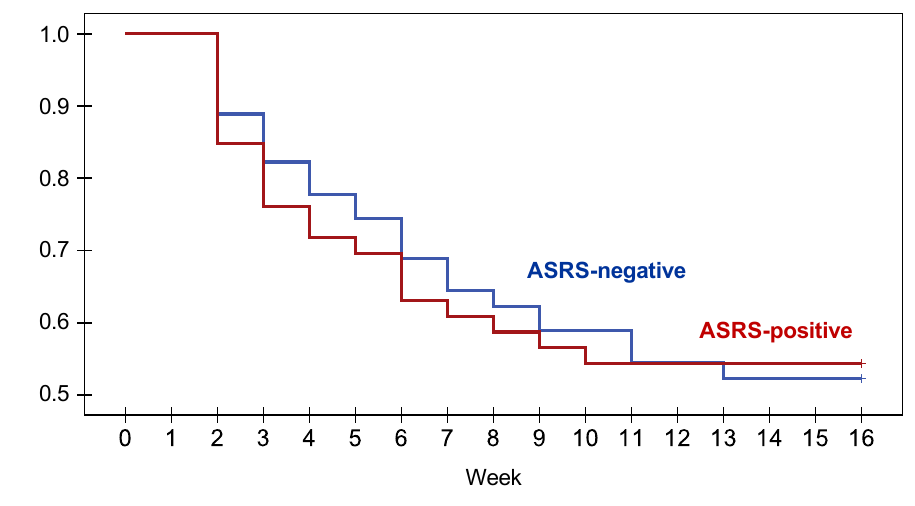
Figure 2. Survival function for dropout ( n = 136).